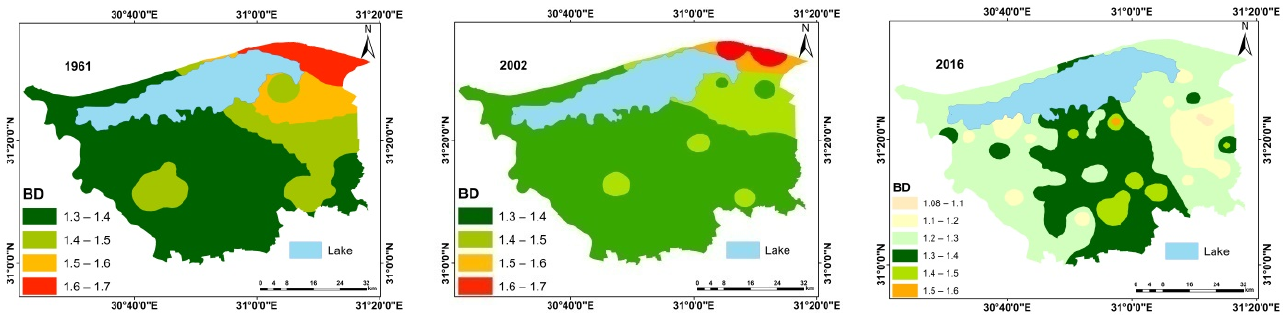
Figure 12. Soil bulk density maps in 1961, 2002, and 2016.